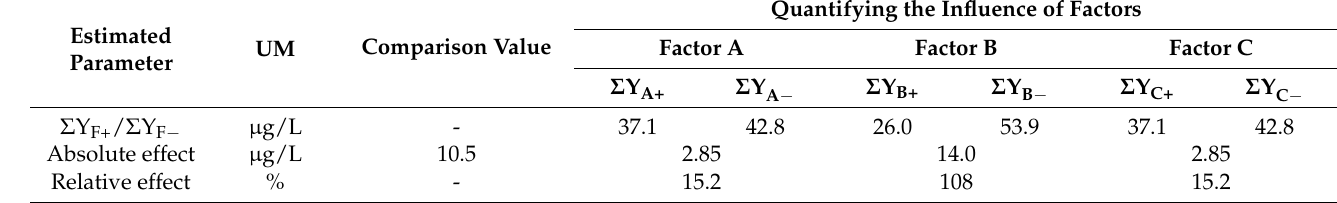
Table 7. Quantification of the variability of the operating parameters of the Hg 2+ determination procedure using DPV technique with SPE-poly L modified electrodes, Test 1.